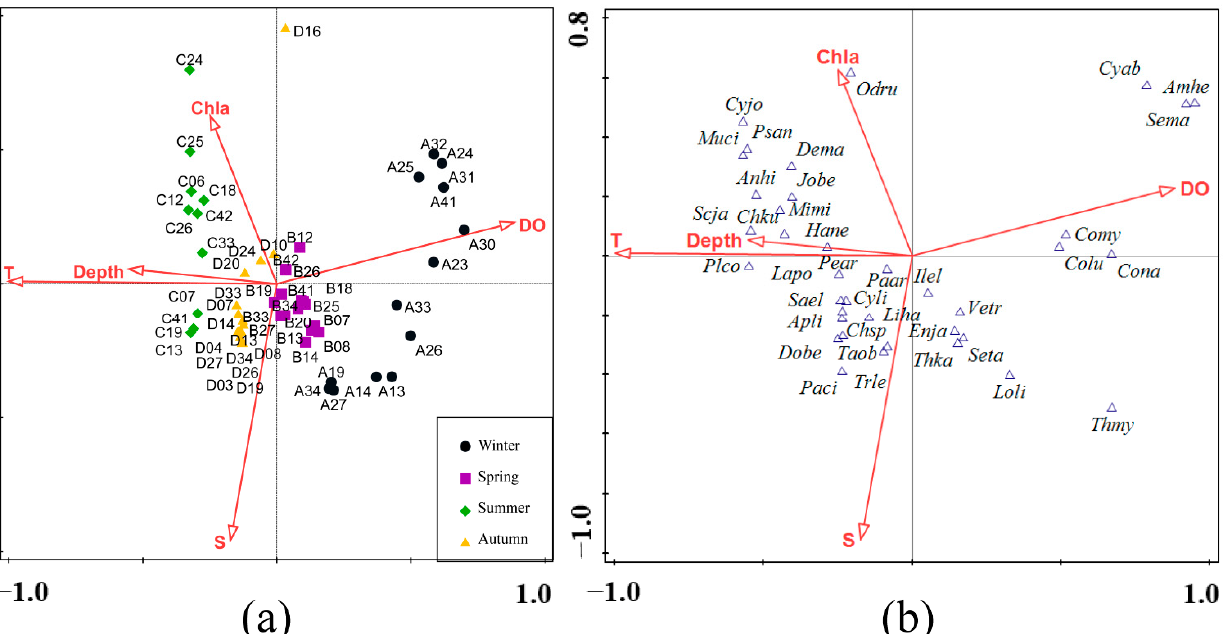
The location of species on the CCA diagram indicates their habitat preferences on an environmental gradient [16] (Figure 7b). From the CCA species ranking chart of mea- sured variables, temperature, depth, salinity, dissolved oxygen, and chlorophyll a most affected the distribution of fish assemblages adjacent to the Yangtze Estuary. In winter, Coilia mystus and Cynoglossus abbreviatus were mainly associated with low temperature and high dissolved oxygen and occurred in the first CCA quadrant. The dominant species in environment relation was 95.31%. The first two axes explained 17.59% and 51.34% of all spring, Pampus argenteus and Setipinna taty , were mainly associated with low chlorophyll variation, respectively.